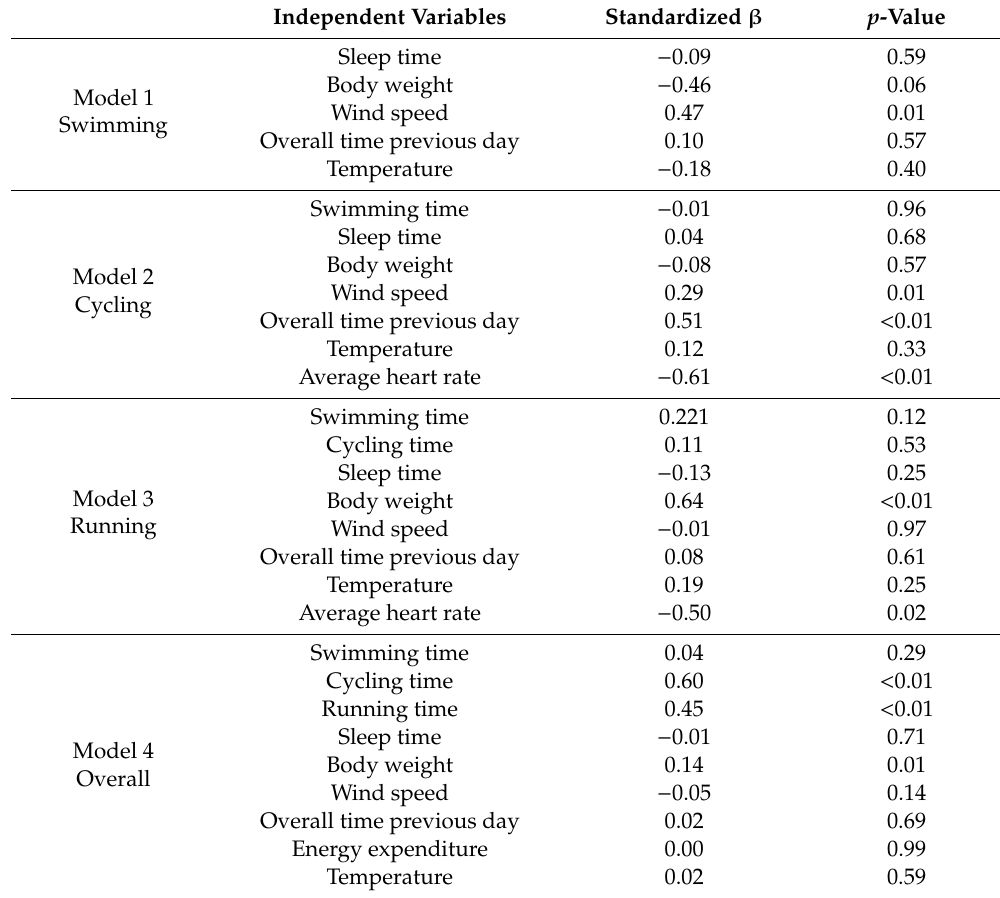
Table 3. Results of the multivariate regression models to test which variable has the highest influence in swimming, cycling, running and overall time in 40 Ironman-distance triathlons in 40